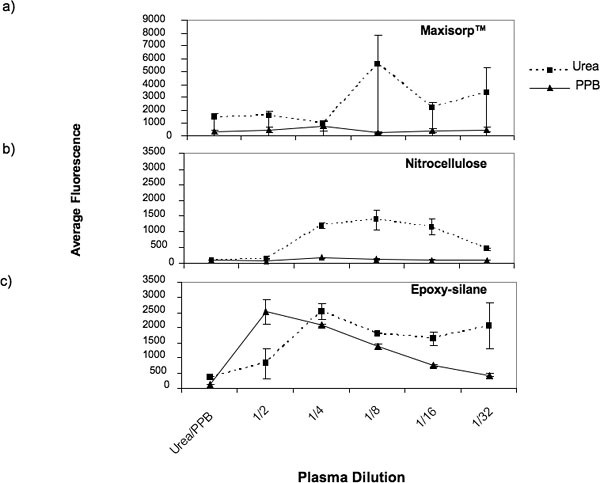
Average fluorescence intensity of triplicate spots containing different plasma dilutions prepared in either PPB or Urea buffers and spotted onto (a) MaxisSorp™, (b) nitrocellulose and (c) epoxy coatedslides. Each buffer was also spotted alone as negative controls on each slide.